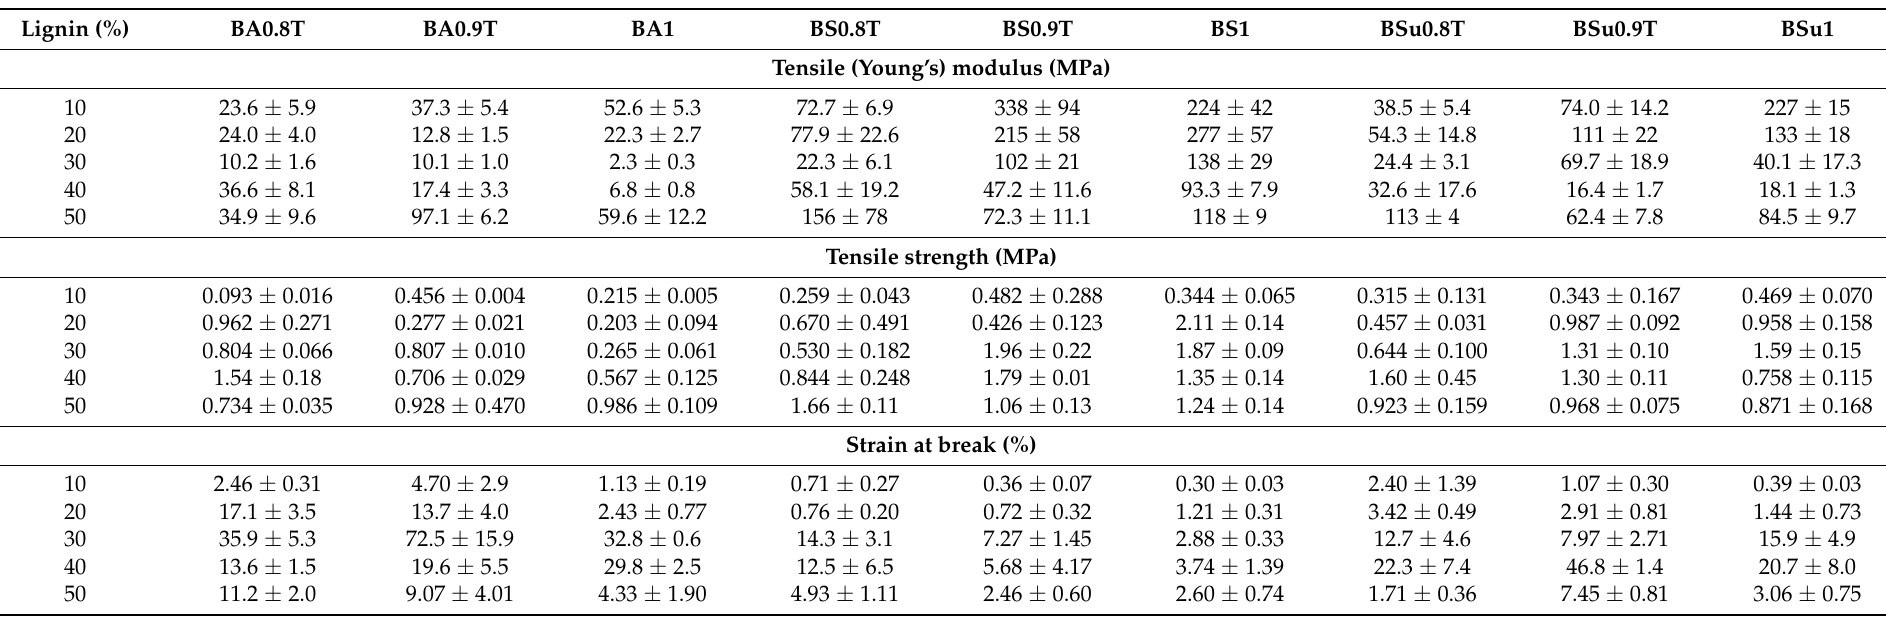
Table 8. Tensile properties (strength, modulus, and strain at break) of the various lignin-co-polyester/amides formulations were determined from tensile stress strain curves. Lignin